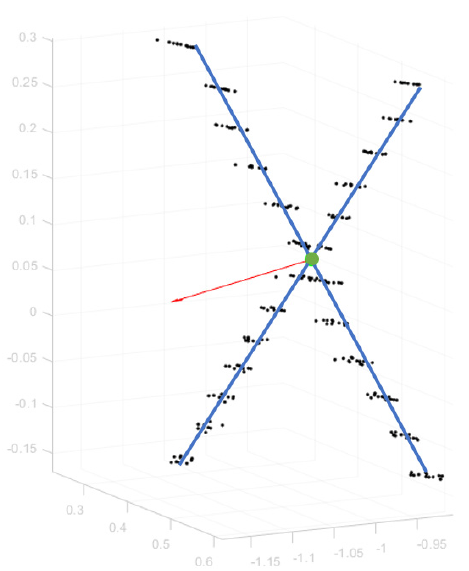
Figure 4. A detailed 3D view of the calibration target with the 3D points corresponding to extracted retroreflective stripes, two detected center lines (in blue), the normal vector of the fitted plane (in red), and the final estimation of the intersection point (in green).